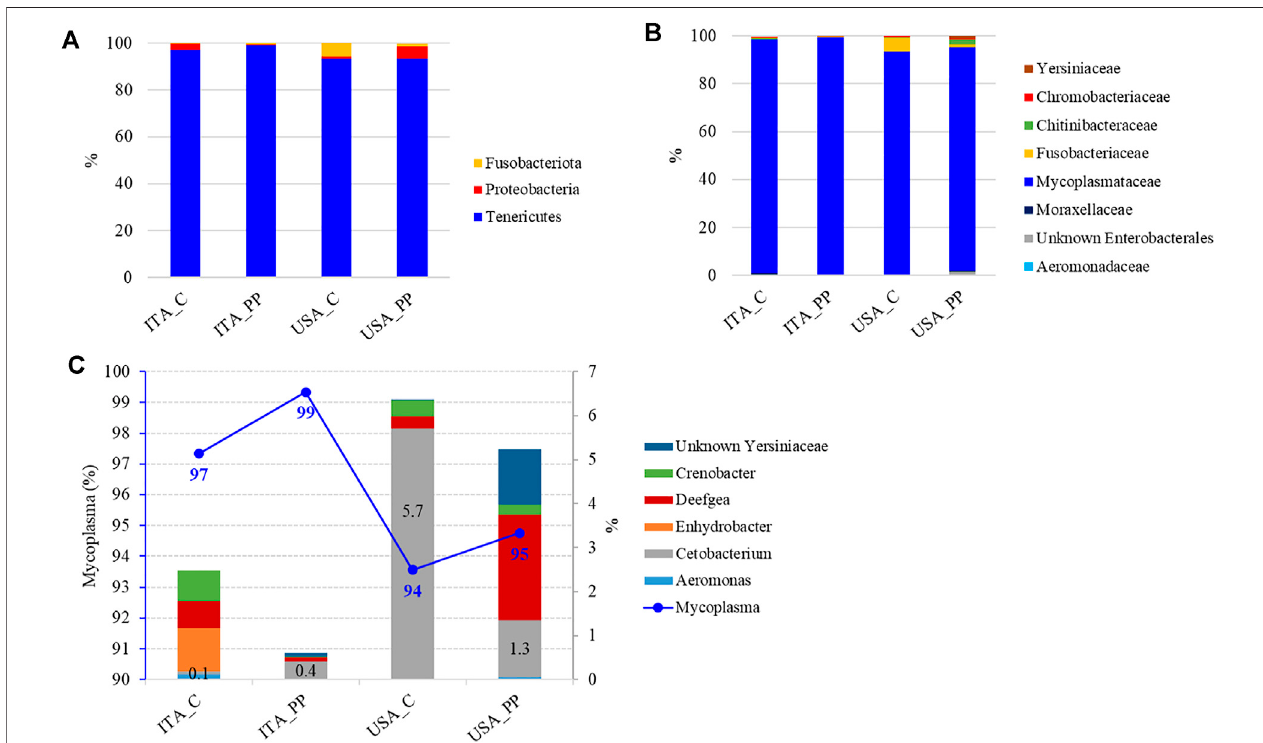
FIGURE 2 | Mean relative abundance (%) of the most prevalent bacterial taxa in gut mucosa of two rainbow trout strains (the United States and ITA) fed experimental diets (C and PP) at phylum (A) , and family (B) , and genus (C) level. ITA_C ( n = 6), ITA_PP ( n = 6), United States_C ( n = 5), and United States_PP ( n = 6). Percentages of the Cetobacterium genus are indicated on histograms. Blueline and the corresponding values indicate the amount of Mycoplasma in each experimental feeding